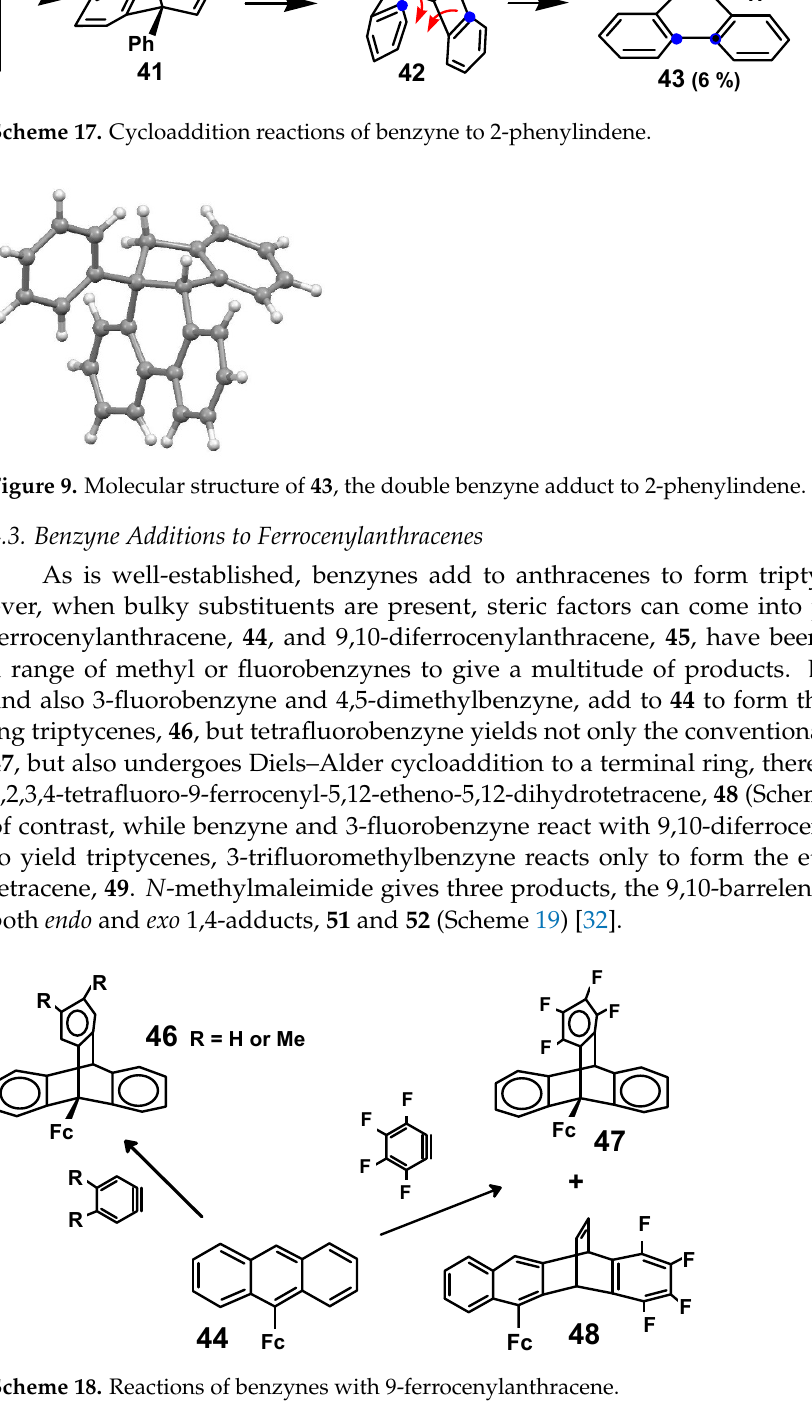
Scheme 18. Reactions of benzynes with